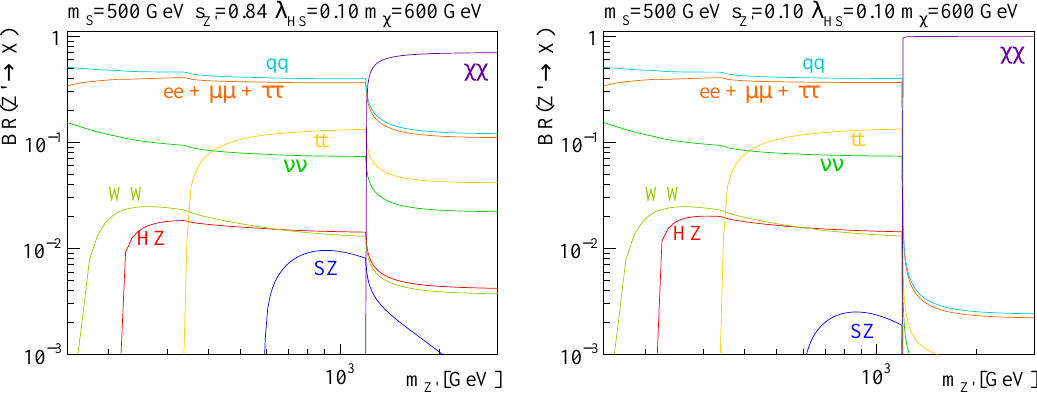
= 500 GeV, λ = 0.1, gauge boson with m X S HS = 0.1 (right). The variable m is varied through Z (cid:48) Z (cid:48) = 100 − 2110 GeV in the right panel. S